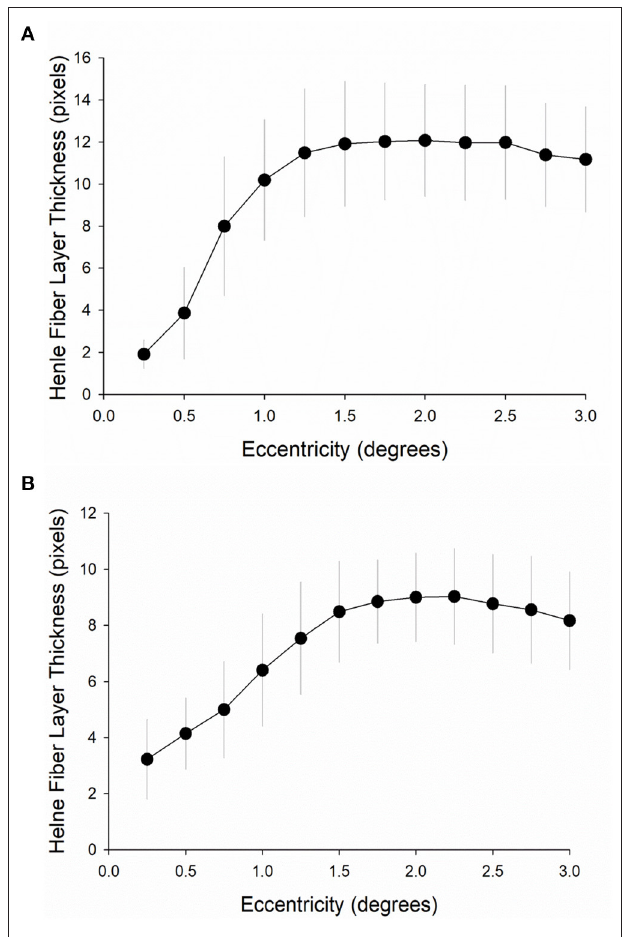
FIGURE 6 | Henle fiber layer thickness at increasing macular eccentricities. Henle fiber layer thickness was measured at 12 different macular eccentricities from 0 ◦ to 3 ◦ from the foveal center in 0.25 ◦ steps (A) in the first cohort ( n = 11) and (B) in the second cohort ( n = 22). Error bars are one standard deviation from the mean (circles).